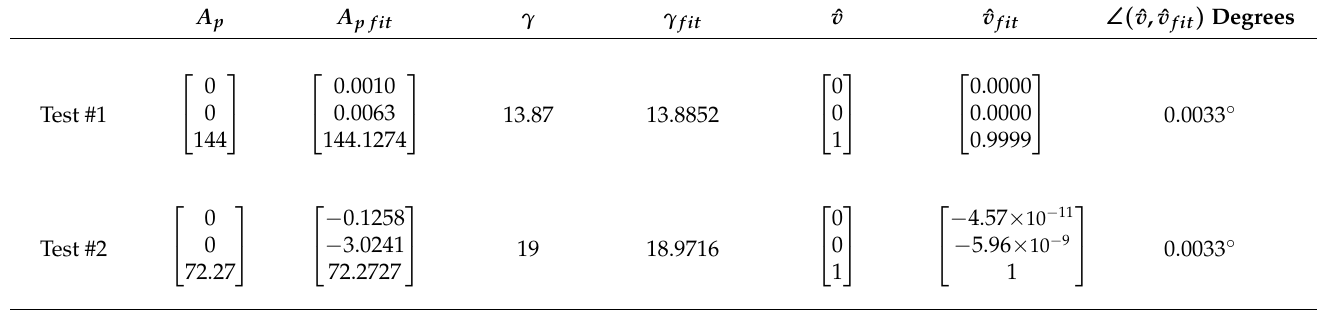
Figure 22. Cone Fit. Fitting-based S extraction. Pink: extracted S support subset. Yellow: fitted g () . Table 7. Cone fit. Set vs. found parameters. Test 1: S extraction based on dihedral angles. Test 2: fitting-based S